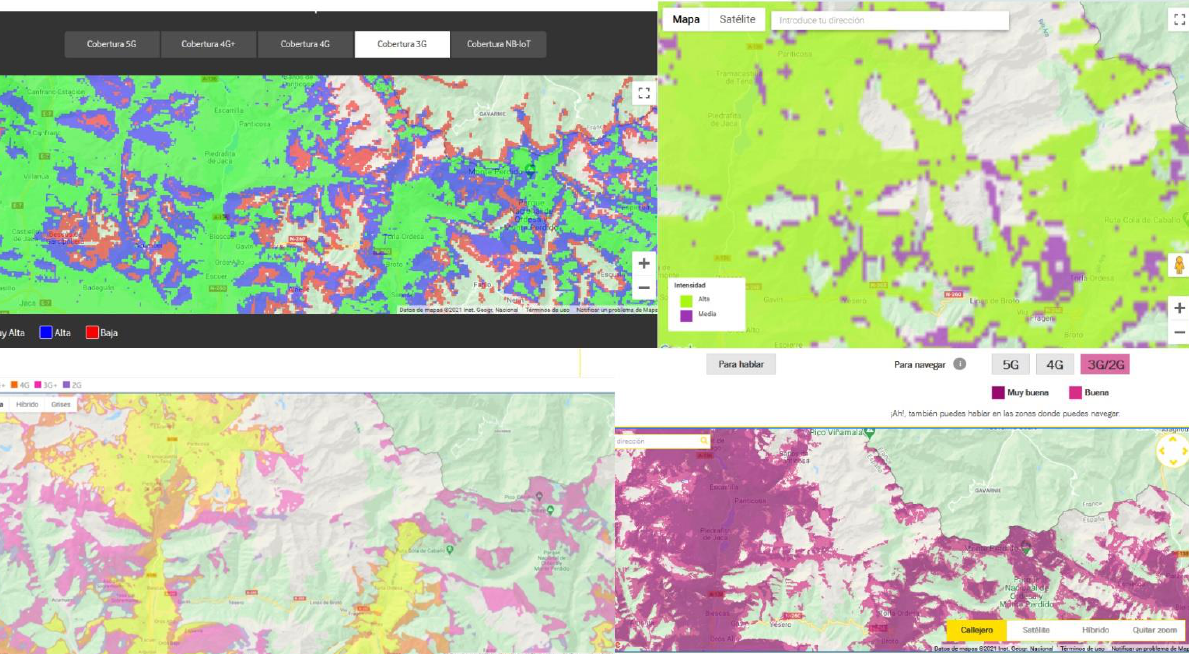
Figure 1. 3G coverage provided by the main telecommunication service provider (TSP) in the Pyrenees area in Spain (source websites from Movistar, Orange, Vodafone and MasMovil, December 2020).